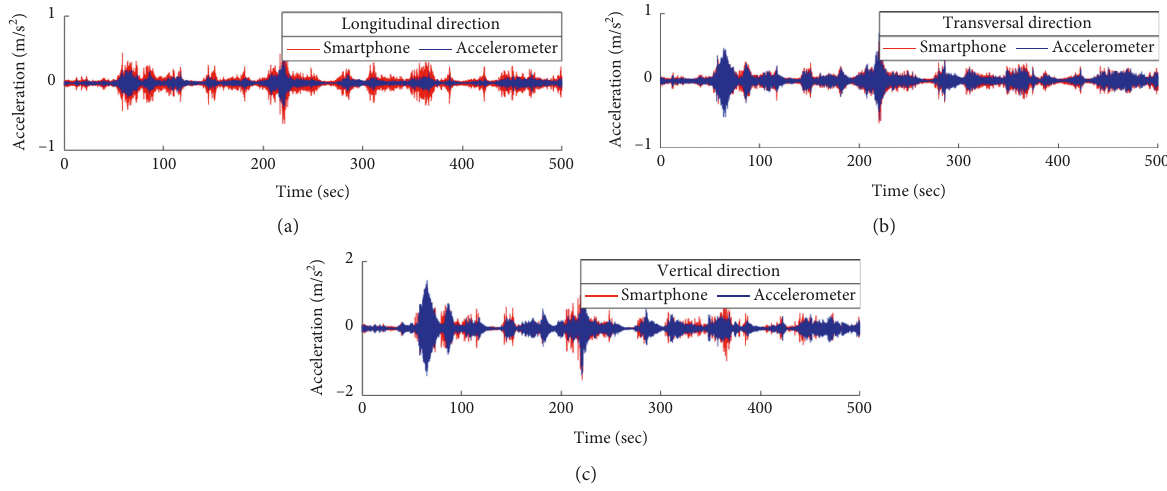
Figure 8: Acceleration time history.